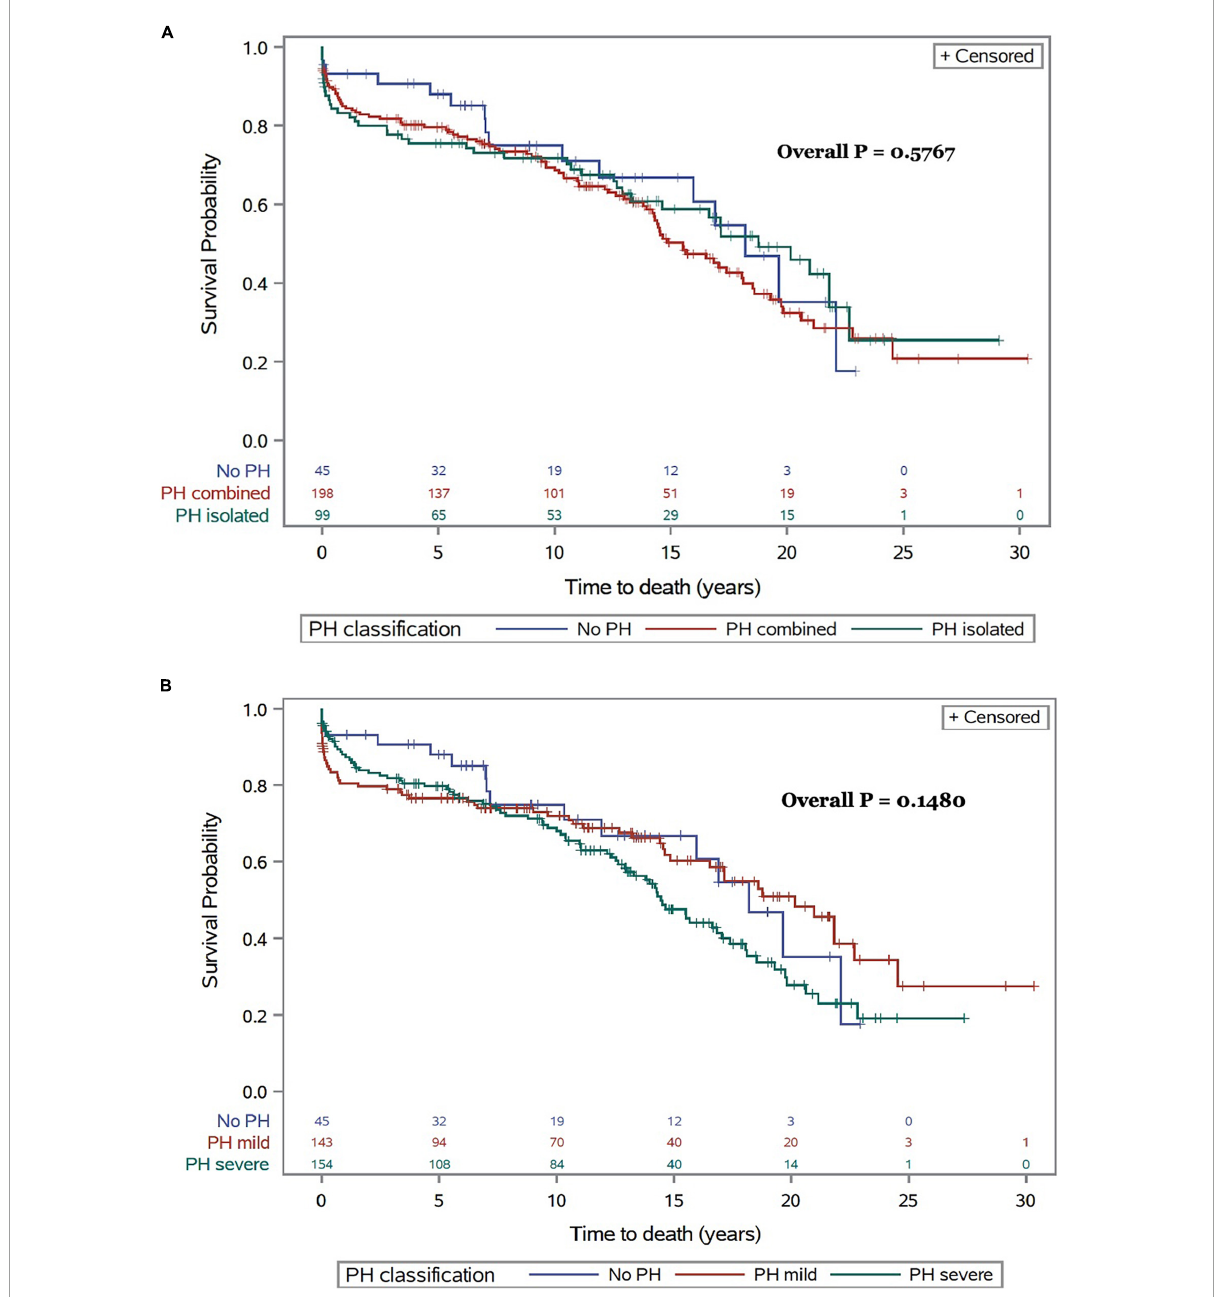
FIGURE3 All-cause mortality following CTx for the whole cohort and for the entire follow-up period in relationship with type (A) and severity of PH (B)